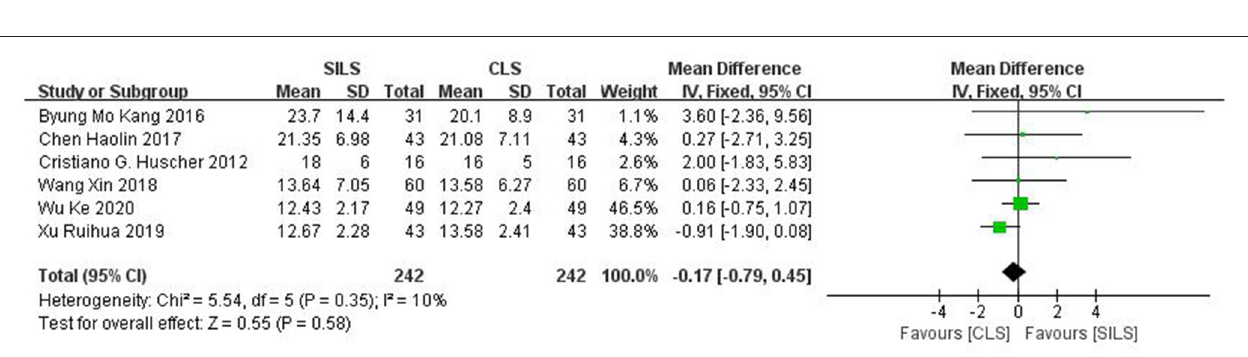
FIGURE 6 | Meta-analysis of number of lymph nodes removed. SILS, single-incision laparoscopic surgery; CLS, conventional laparoscopic surgery.